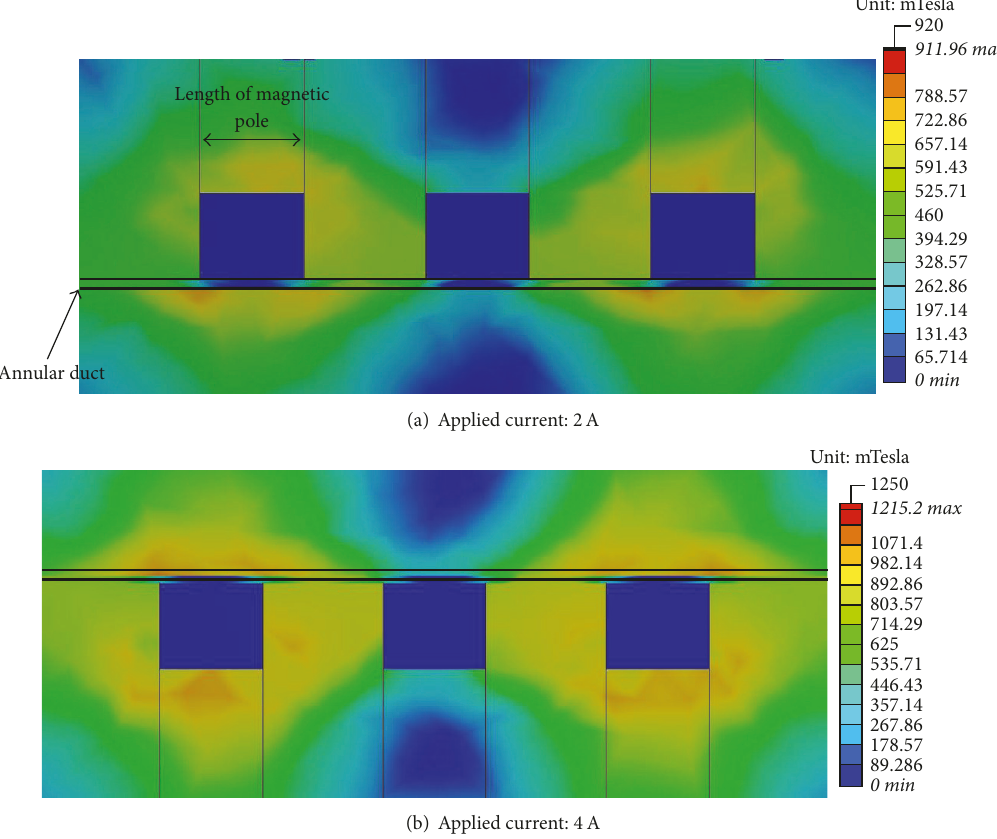
Figure 8: FEM result for magnetic circuit of the proposed MR damper.